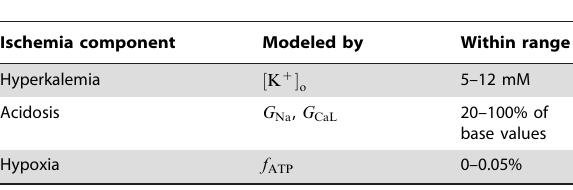
Table 1. Summary of changes applied to the TNNP06